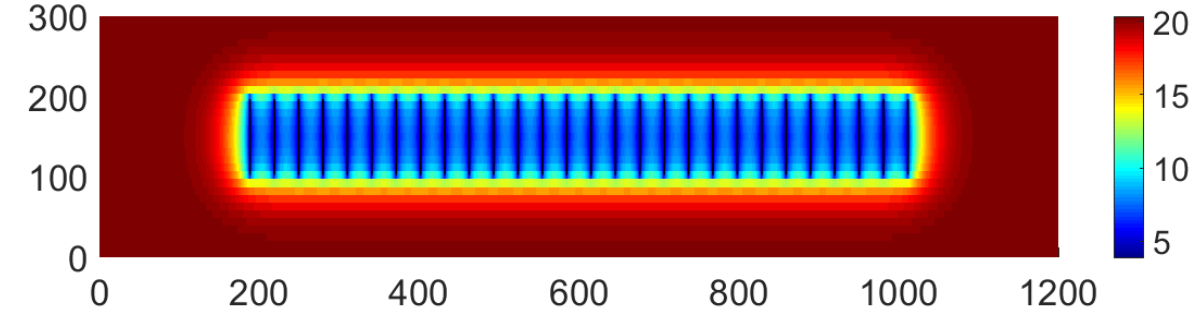
Figure 20. Pressure contours after 1600 days for the Barnett shale reservoir (simulation AE1).